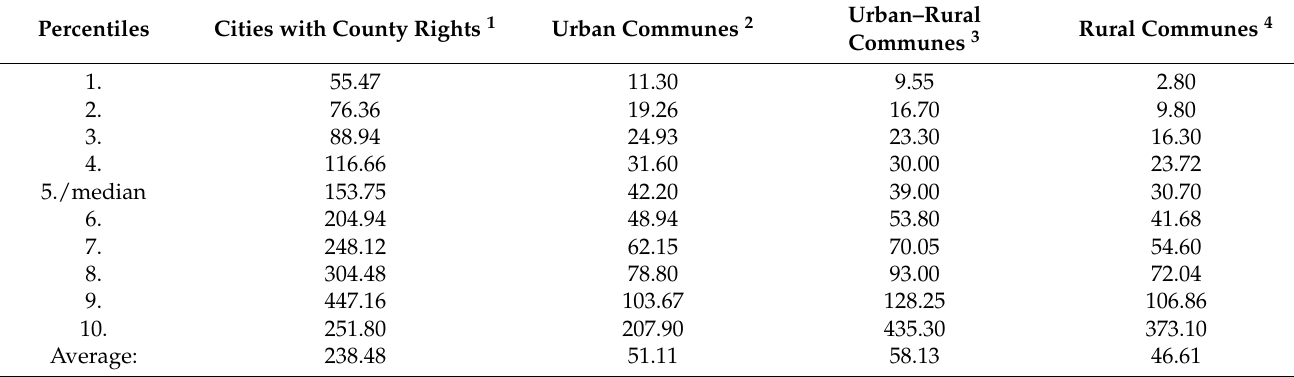
Table 2. Percentiles and the average increase in the length of the sewage network in the respective types of the communes [km]. Percentiles